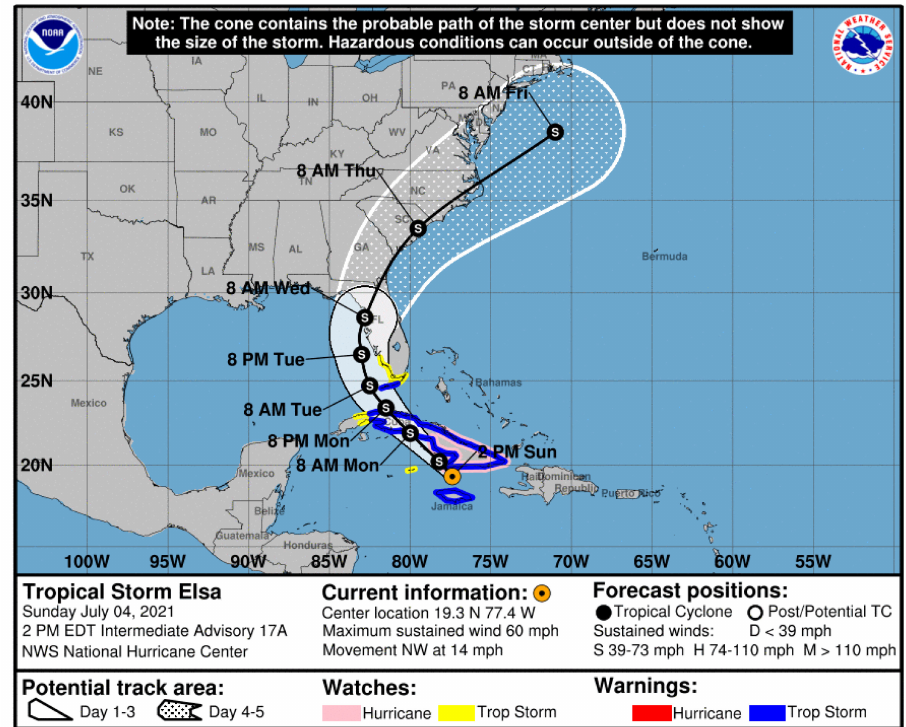
Figure 7. Five-day cone of probability from Tropical Storm Elsa advisory issued on 4 July 2021